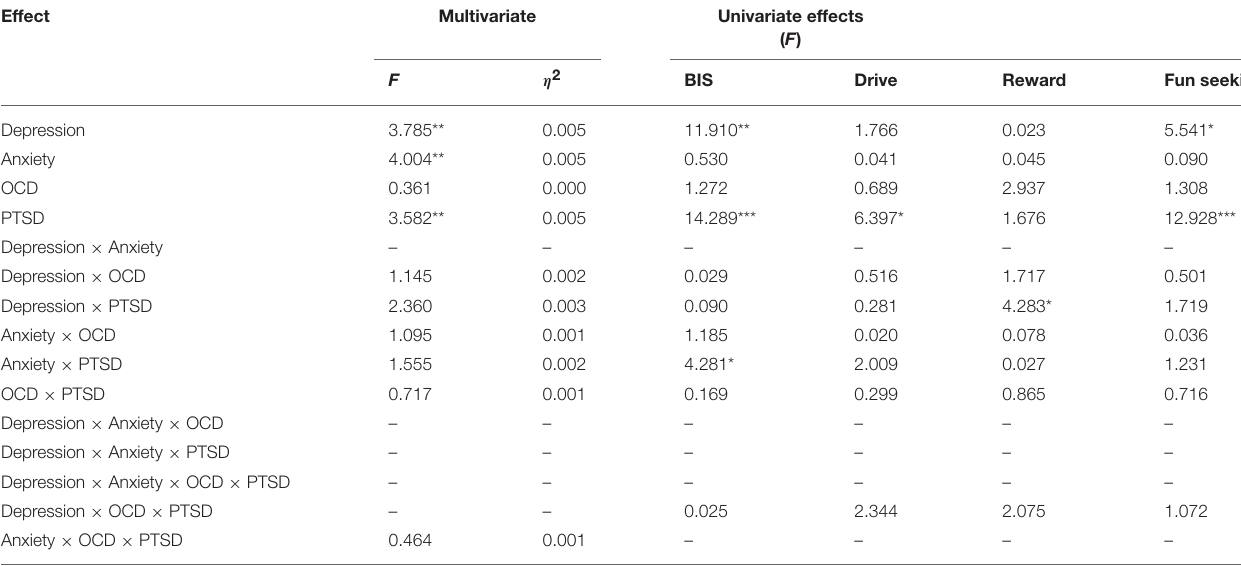
TABLE 6 | Multivariate and univariate analyses of variance for BIS and BAS subscales by the symptoms of depression, anxiety, OCD, and